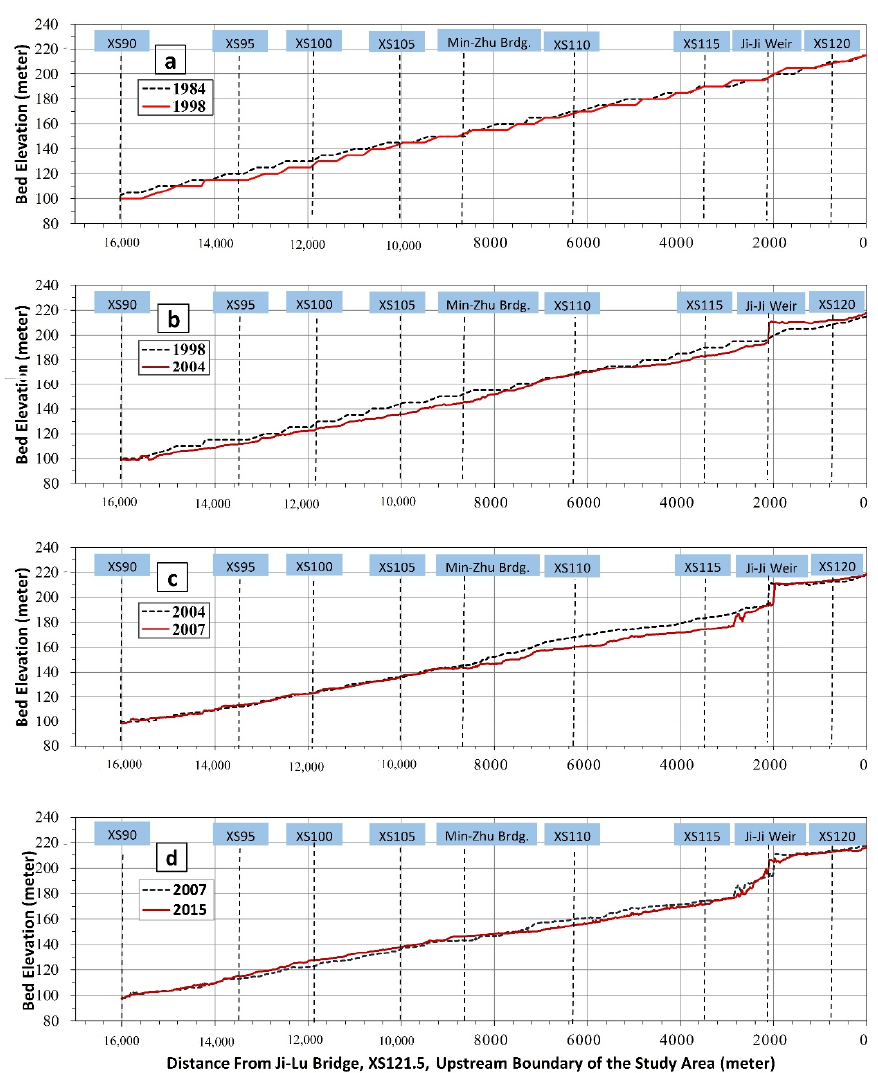
Figure 2. Longitudinal profiles during four time periods corresponding to the four stages: ( a ) period 1984–1998; ( b ) period 1998–2004; ( c ) period 2004–2007; ( d ) period 2007–2015.